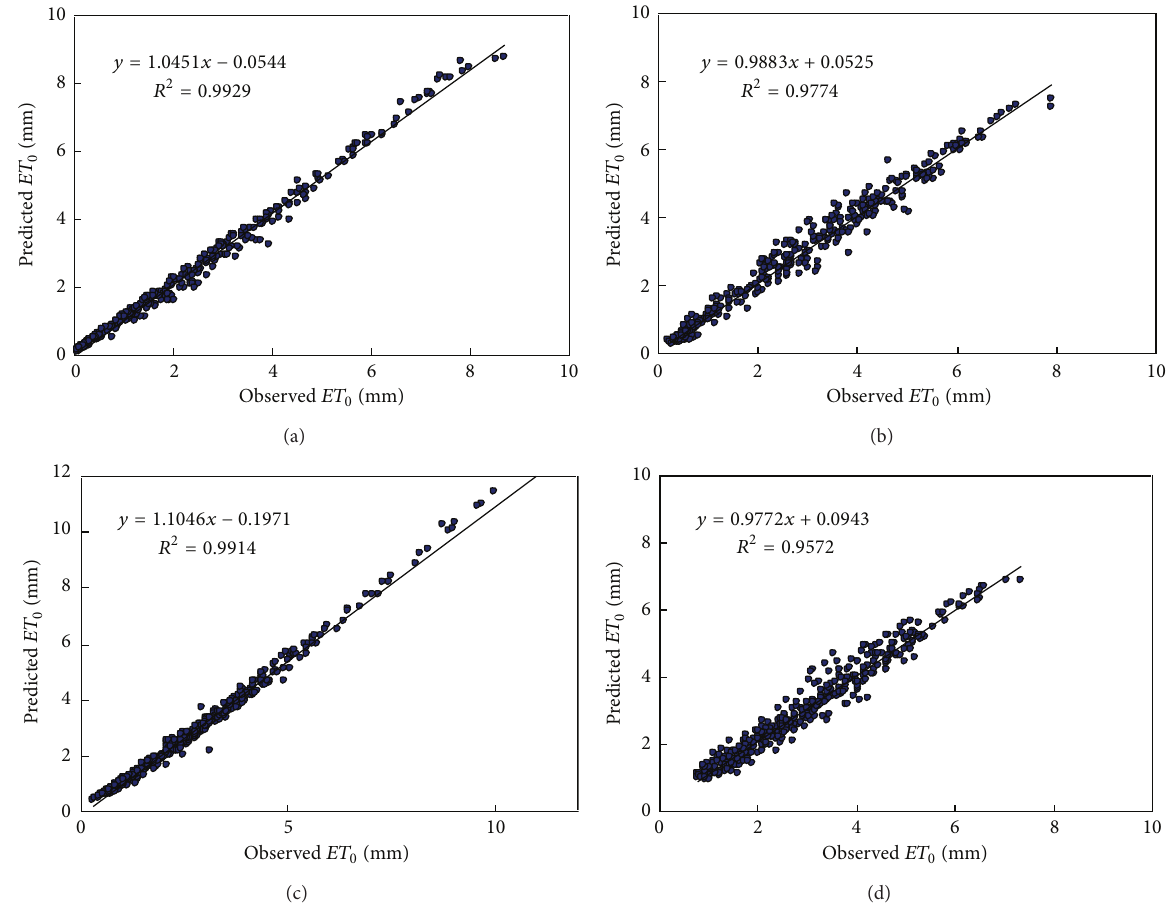
Figure 9: The regression relationship between daily 𝐸𝑇 0 forecasted by chaotic model and that computed with observed weather variables: (a) Baotou station; (b) Zhangbei station; (c) Kaifeng station; (d) Shaoguan